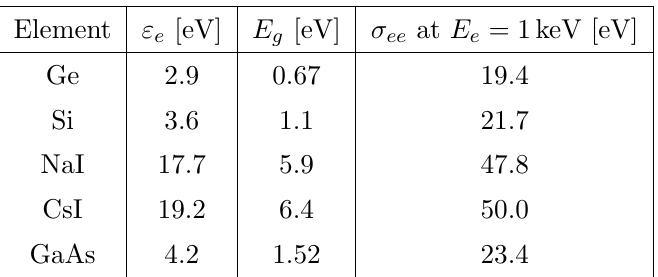
Table 1 . Mean energy to create an electron-hole pair ( " e ), band gap energy ( E g ), and signal width ( (cid:27) ee ) at ionization energies of 1 keV from eq. (4.2) in various semiconductors (Si, Ge) and scintillators (NaI, CsI,